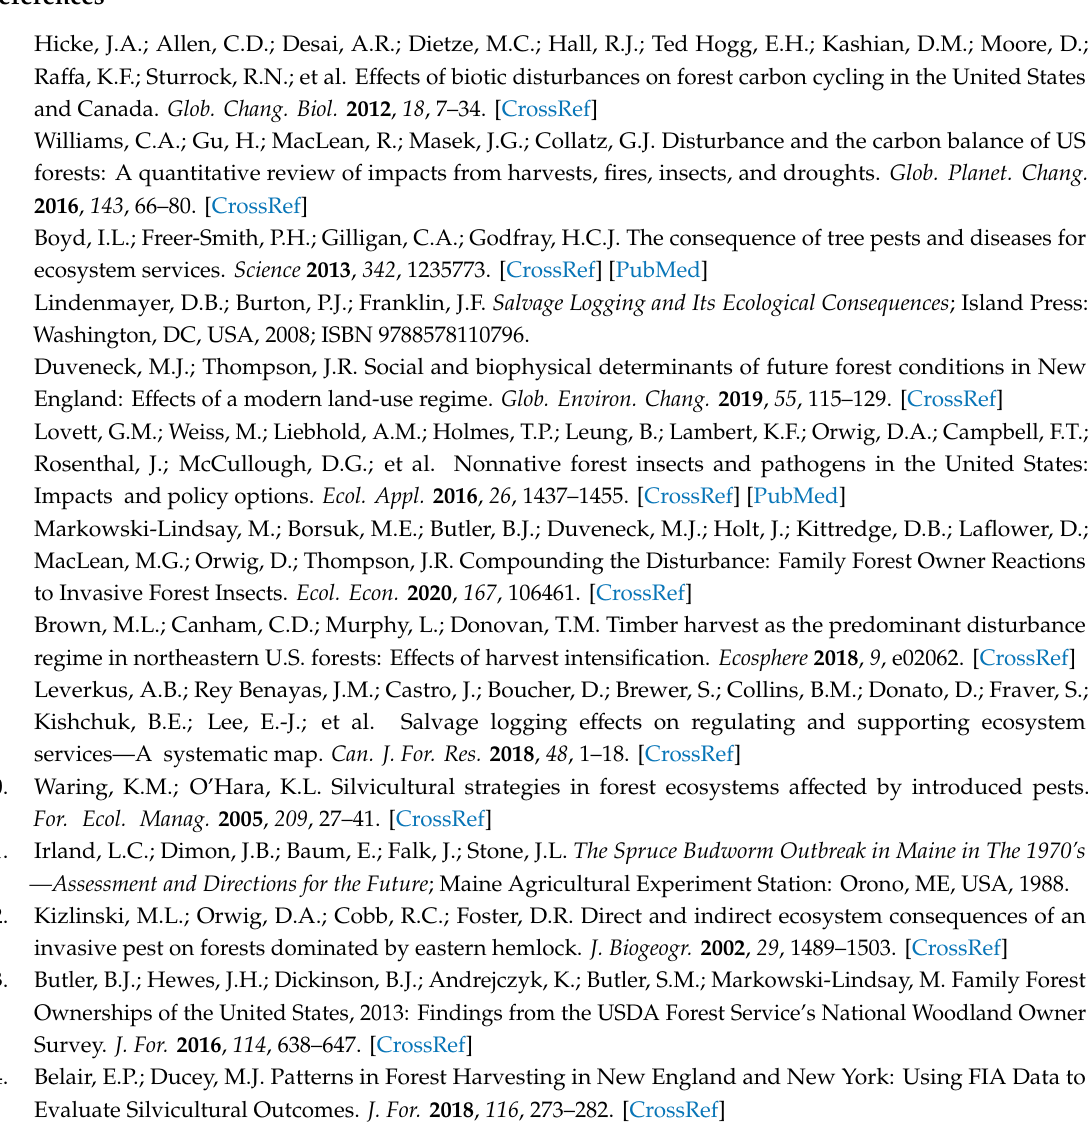
Table A1. The most valuable species, listed in order of average value from stumpage reports, for each harvest region. Average values of species are listed in $ per thousand board feet (Mbf) and averaged from the available stumpage reports from each region from 2017–2019, though exact stumpage prices were not used in the model, only ranks. Note that due to its lower abundance, white oak was aggregated with other oak species in some stumpage reports; therefore white oak’s value is more approximate than the other species and its rank in the south was augmented by expert knowledge and Belair and Ducey [14]. North (Northern NH and VT) South Sugar maple ( Acer saccharum ) ($315 / Mbf) Red oak ( Quercus rubra ) ($333 / Mbf) Red oak ( Quercus rubra ) ($310 / Mbf) Sugar maple ( Acer saccharum ) ($284 / Mbf) Black cherry ( Prunus serotina ) ($212 / Mbf) Black cherry ( Prunus serotina ) ($231 / Mbf) White oak ( Quercus alba ) ($170 / Mbf) White oak ( Quercus alba ) ($170 / Mbf) Yellow birch ( Betula alleghaniensis ) ($158 / Mbf) Yellow birch ( Betula alleghaniensis ) ($177 / Mbf) Red spruce ( Picea rubens ) ($120 / Mbf) White pine ( Pinus strobus ) ($105 /